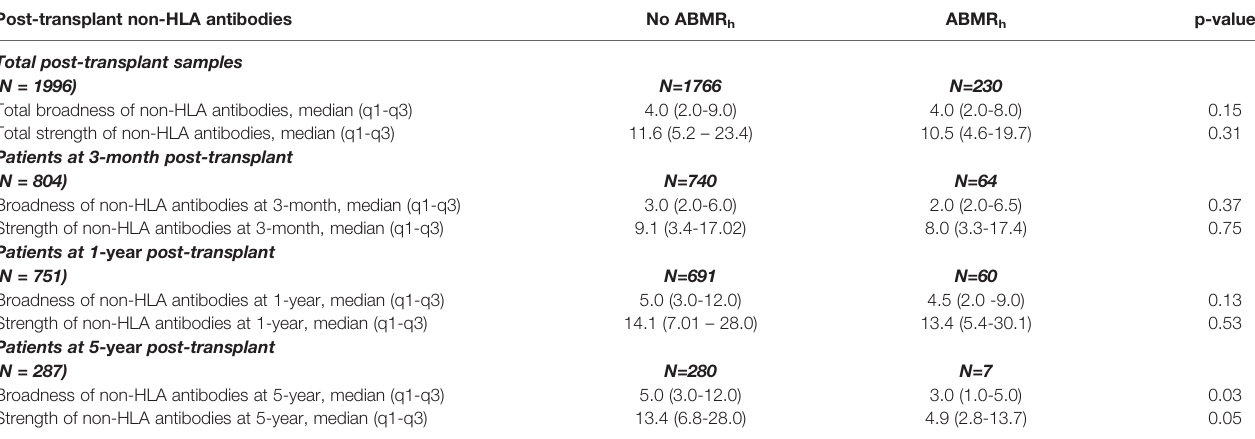
TABLE 5 | Comparison of the medians of the strength and the broadness of posttransplant non-HLA antibody samples between patients with and without ABMR h . Post-transplant non-HLA